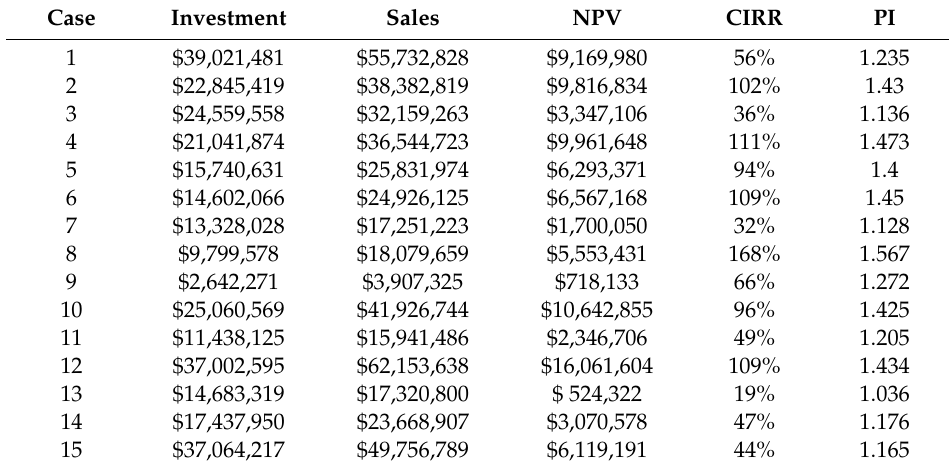
Table 4. The profitability of real estate projects in Santiago. Source: Prepared and calculated by authors based on data obtained from Conservador de Bienes Ra í ces de Santiago, InCiti.com and the Ministry of the Environment.